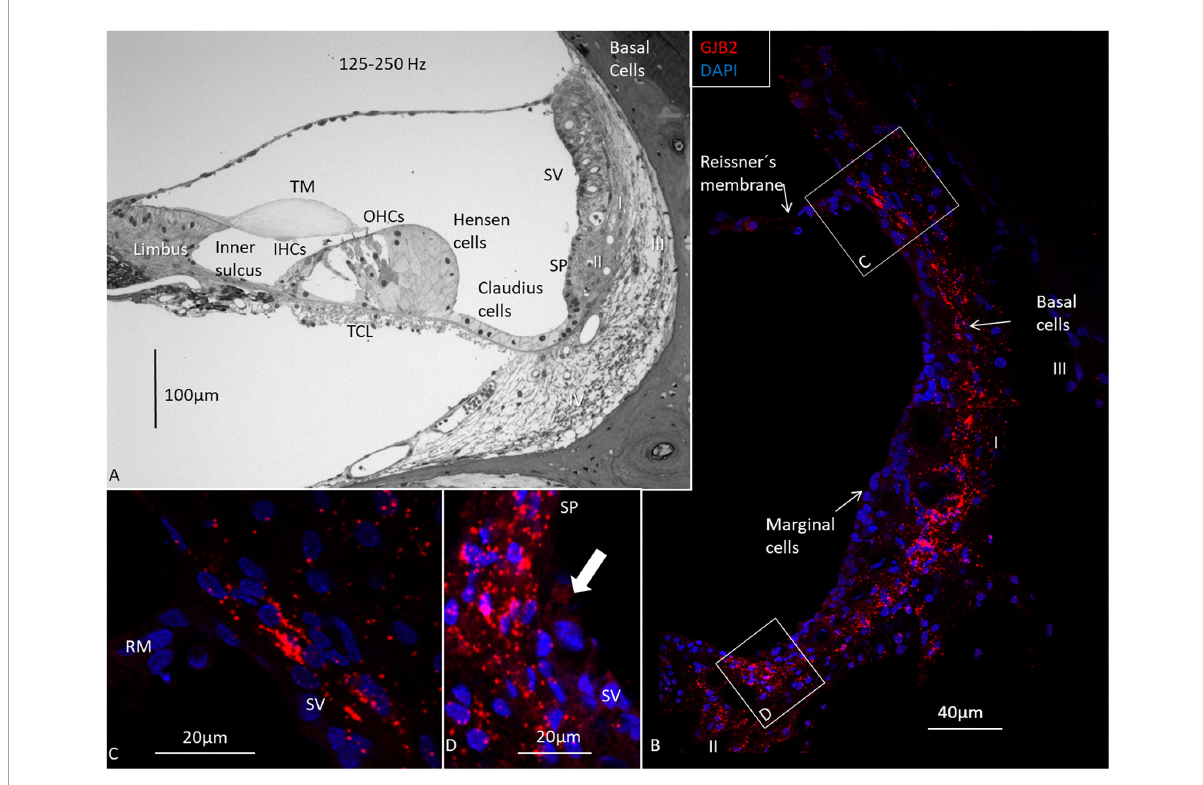
FIGURE4 Light microscopy and confocal microscopy of the apical turn of the human cochlea at the frequency region 125–250 Hz. (A) A semi-thin section shows the stria vascularis (SV) and the relatively thin spiral ligament containing four different types of fibrocytes (I-IV). There is no suprastrial connective tissue layer containing type V fibrocytes. A thin layer of basal cells can be seen next to the type I fibrocytes. Type II fibrocytes lie beneath the spiral prominence (SP) epithelium. (B) Distribution of GJB2 gene transcripts in the lateral wall. GJB2 gene transcripts are concentrated at the basal cell (BC) region, while the marginal cells show no gene transcripts. A few red puncta can be observed at the intermediate cells. Gene transcripts are located in type I fibrocytes. Framed areas are shown in higher magnification in (C,D) . (C) Expression of GJB2 at the angle between the Reissner’s membrane (RM) and SV. There are no transcripts in RM. (D) Enlargement of the angle between the SV with transcript-containing basal cells reaching the SP epithelium (arrow). IHCs, inner hair cells; OHCs, outer hair cells; TM, tectorial membrane; Limbus, spiral